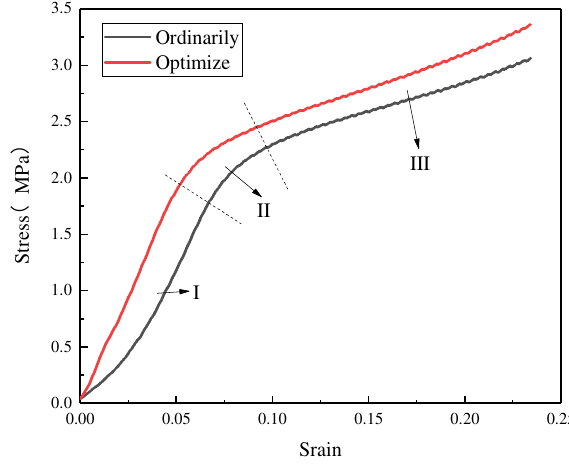
8 of 25 Figure 5. Compression test results: ( a ) conventional BCC structure and ( b ) optimized BCC struc- ture. The comparison shows that the static compression experiments using FEM simula- tions are basically the same, in terms of stress and deformation distribution, as the actual compression experiments in terms of the location of the severe deformation, with both showing tensile bending deformation of the cylindrical connecting rod. For the two dif- ferent structures, the comparison clearly shows that the optimized structure has a huge advantage in terms of compressive deformation and is able to produce smaller compres- sive deformations with good mechanical properties. Figure 6 shows the stress–strain curves of the two structures, in which three regions can be defined as the deformation history of the BCC’s structure elastic loading (I), elas- toplastic collapse (II), and plastic collapse (III), respectively. Combined with the analysis in Figure 5, it is concluded that at the beginning of the pressure loading is mainly elastic– plastic deformation with bending and stretching as the dominant behavior; then, as the compression increases, the length of the unit column strut is too short and cannot continue to withstand the bending, and continuous collapse occurs; this produces plastic defor-